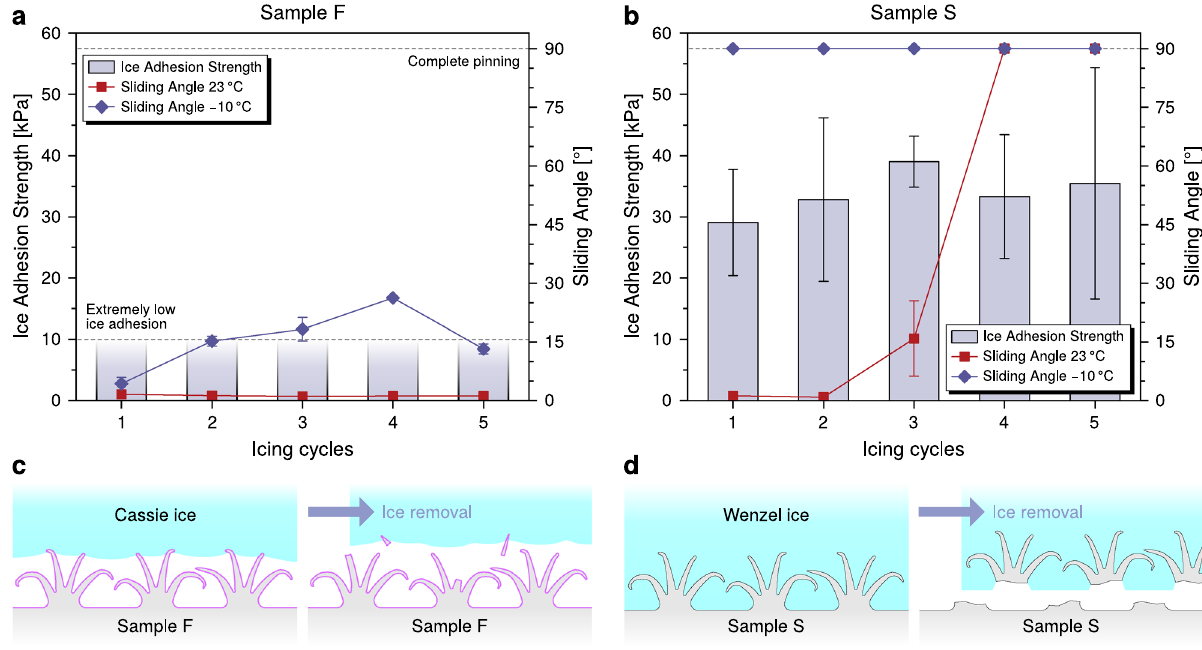
Figure 5. Ice adhesion and wetting at different temperatures. ( a , b ) Correlation between ice adhesion and wetting at 23 °C and − 10 °C for ( a ) sample F and ( b ) sample S. The values of sliding angle reported at a given cycle are those measured before the cycle. Error bars are equal to one standard deviation. ( c , d ) Schemes of Cassie ice on sample F ( c ) and Wenzel ice on sample S ( d ) and their respective mode of damage to the